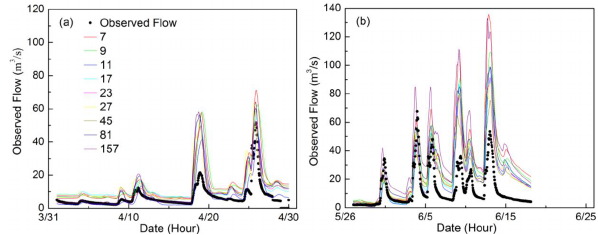
Fig. 6 Calculated hydrographs at Oxford with scenarios of: (a) April; (b) June. 4 Fig. 6. Calculated hydrographs at Oxford with scenarios of (a) April 5 and (b)